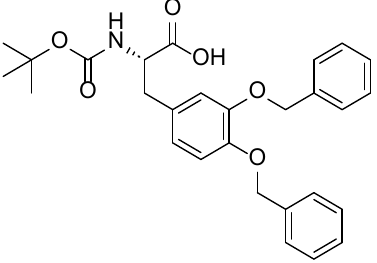
Figure 2. Chemical structure of the gelator Boc-L-DOPA(Bn) 2